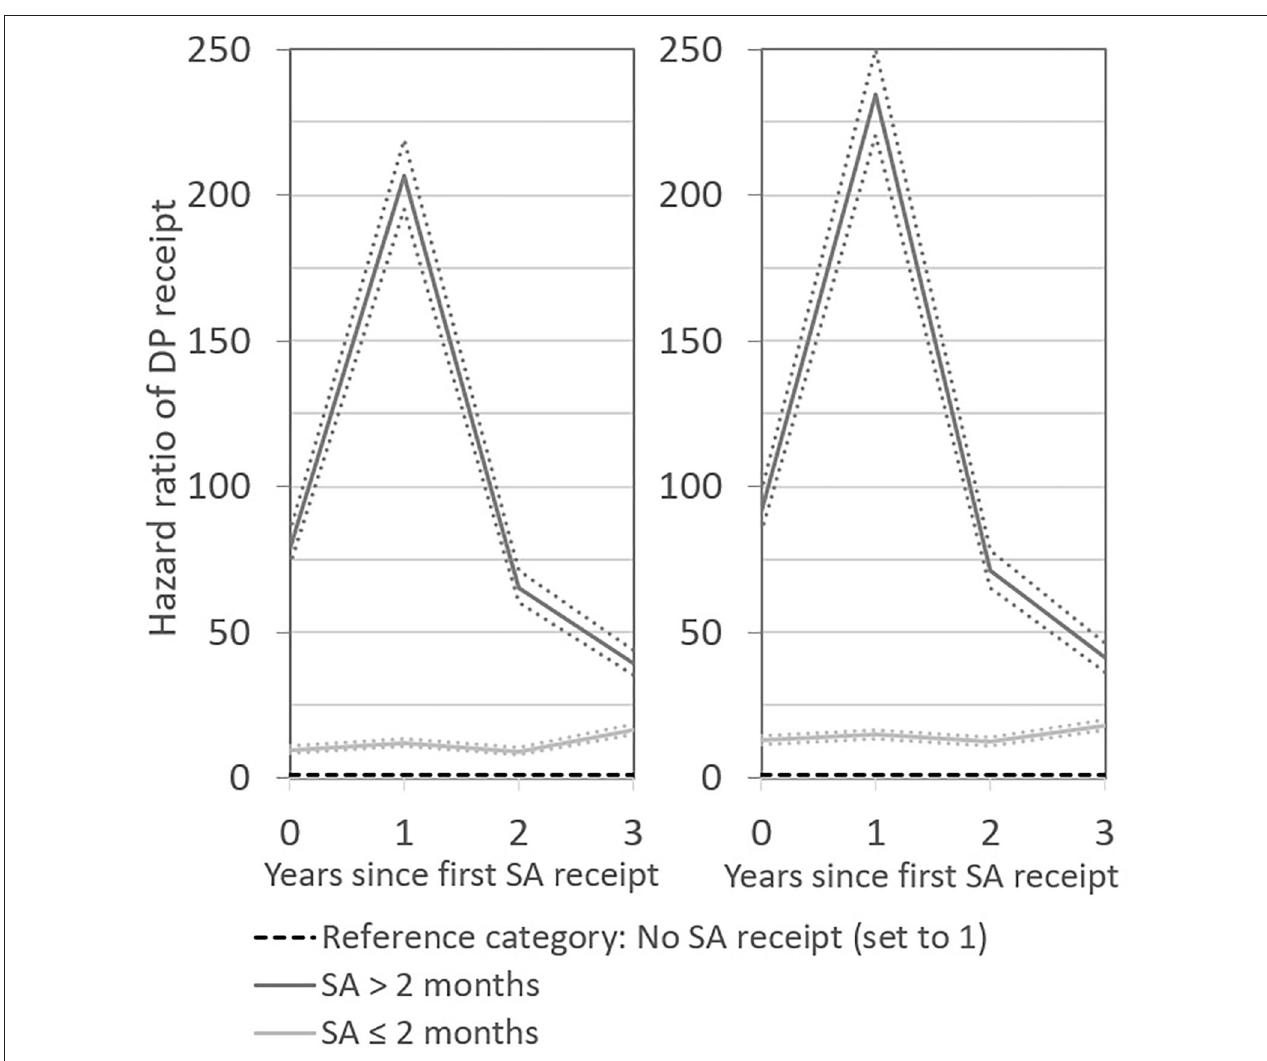
FIGURE 2 | Hazard ratios of DP receipt after first SA receipt by length of SA receipt in the short term. Results for men are presented in the left-hand panel and for women in the right-hand panel. Numbers reported are unadjusted and adjusted estimates with 95 percent confidence